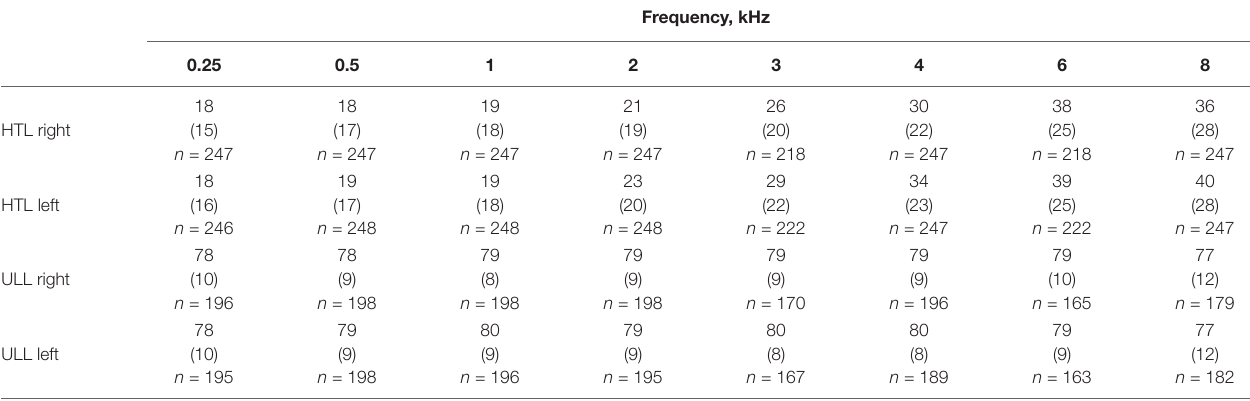
TABLE 1 | Means (SDs) of hearing threshold levels (HTLs) and uncomfortable loudness levels (ULLs) in dB HL for each ear of the study population across different frequencies.